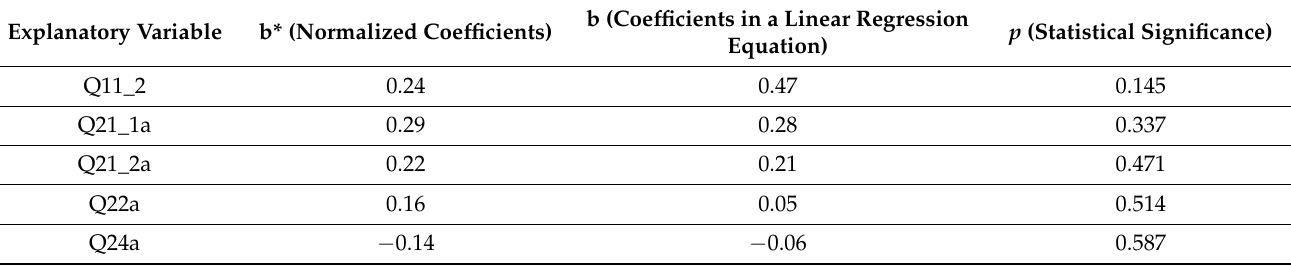
Table 7. Multiple linear regression coefficients for Q28a vs. Q11_2, Q21_1a, Q21_2a, Q22a, and